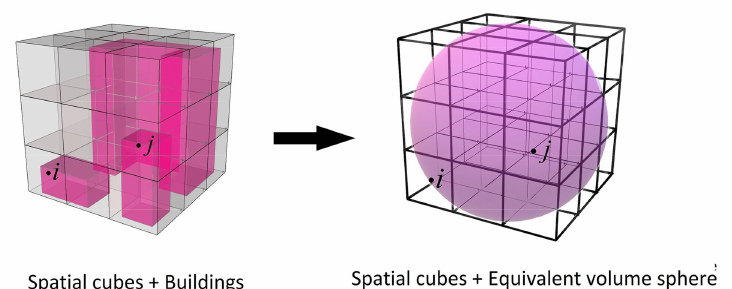
Figure 5. Urban buildings and their equivalent volume sphere